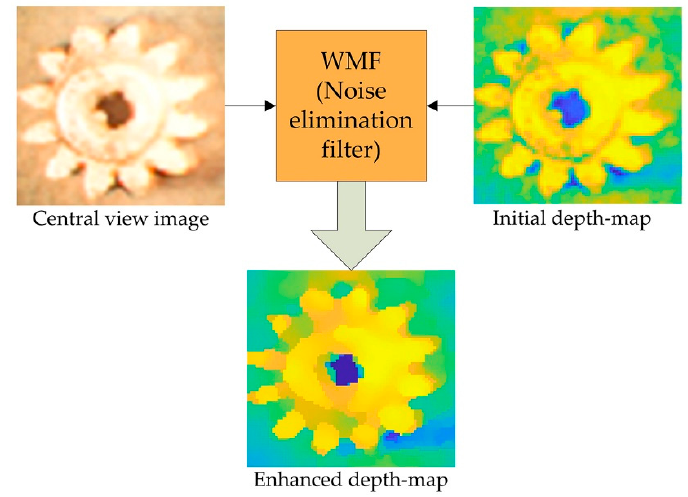
Figure 5. Internal noise reduction using the WMF.